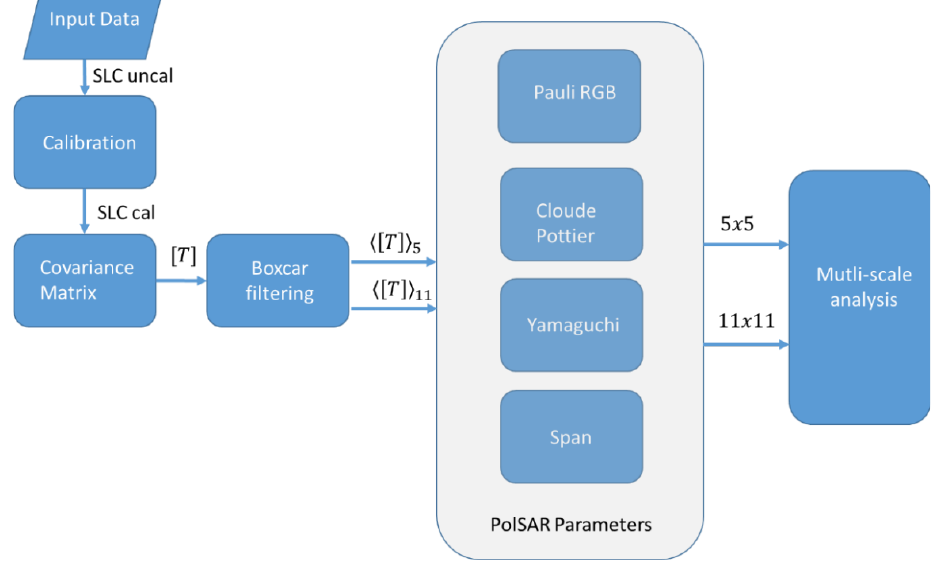
Figure 1. Block diagram outlining the methods of the study. The covariance matrix was built before main multi-scale analysis. Note that Pauli RGB refers to the RGB image and without it, the other steps would not have been carried